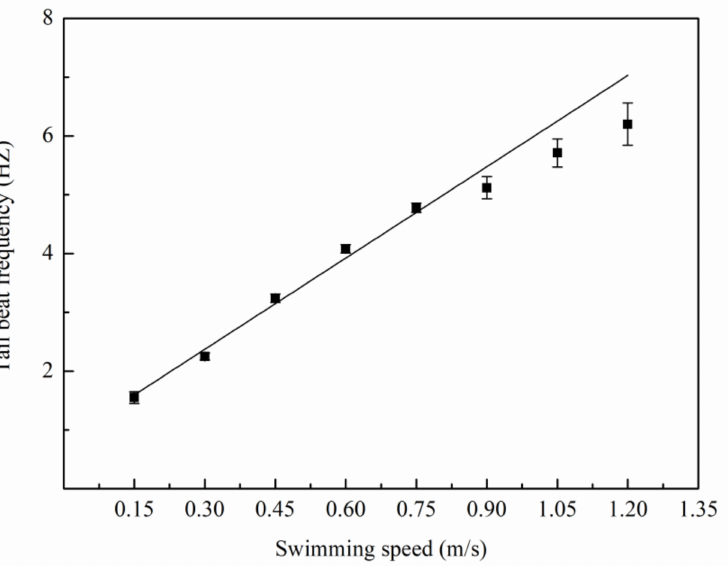
Figure 3. Tail beat frequency (TBF, mean ± SEM) as a function of swimming speed (linear function: TBF = 0.82 + 5.2 U s , R 2 = 0.977, p < 0.001).